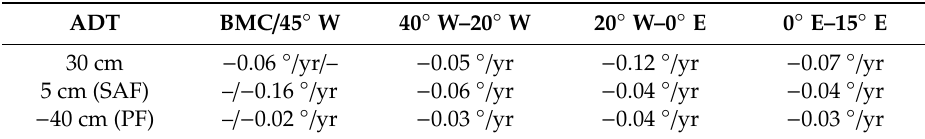
Figure 4. ( a ) Sea level trend (mm/yr) pattern without the SAMSL trend from CMEMS superimposed with yearly Absolute Dynamic Topography (ADT) contours of 30 cm (representative of the BMC), 5 cm (Subantarctic Front) and −40 cm (Polar Front). Panel ( b ) is a zoom in on panel ( a ). The colored contours represent the yearly position of the 30 cm, 5 cm and −40 cm ADT contours, from 1993 (blue) to 2017 (red).